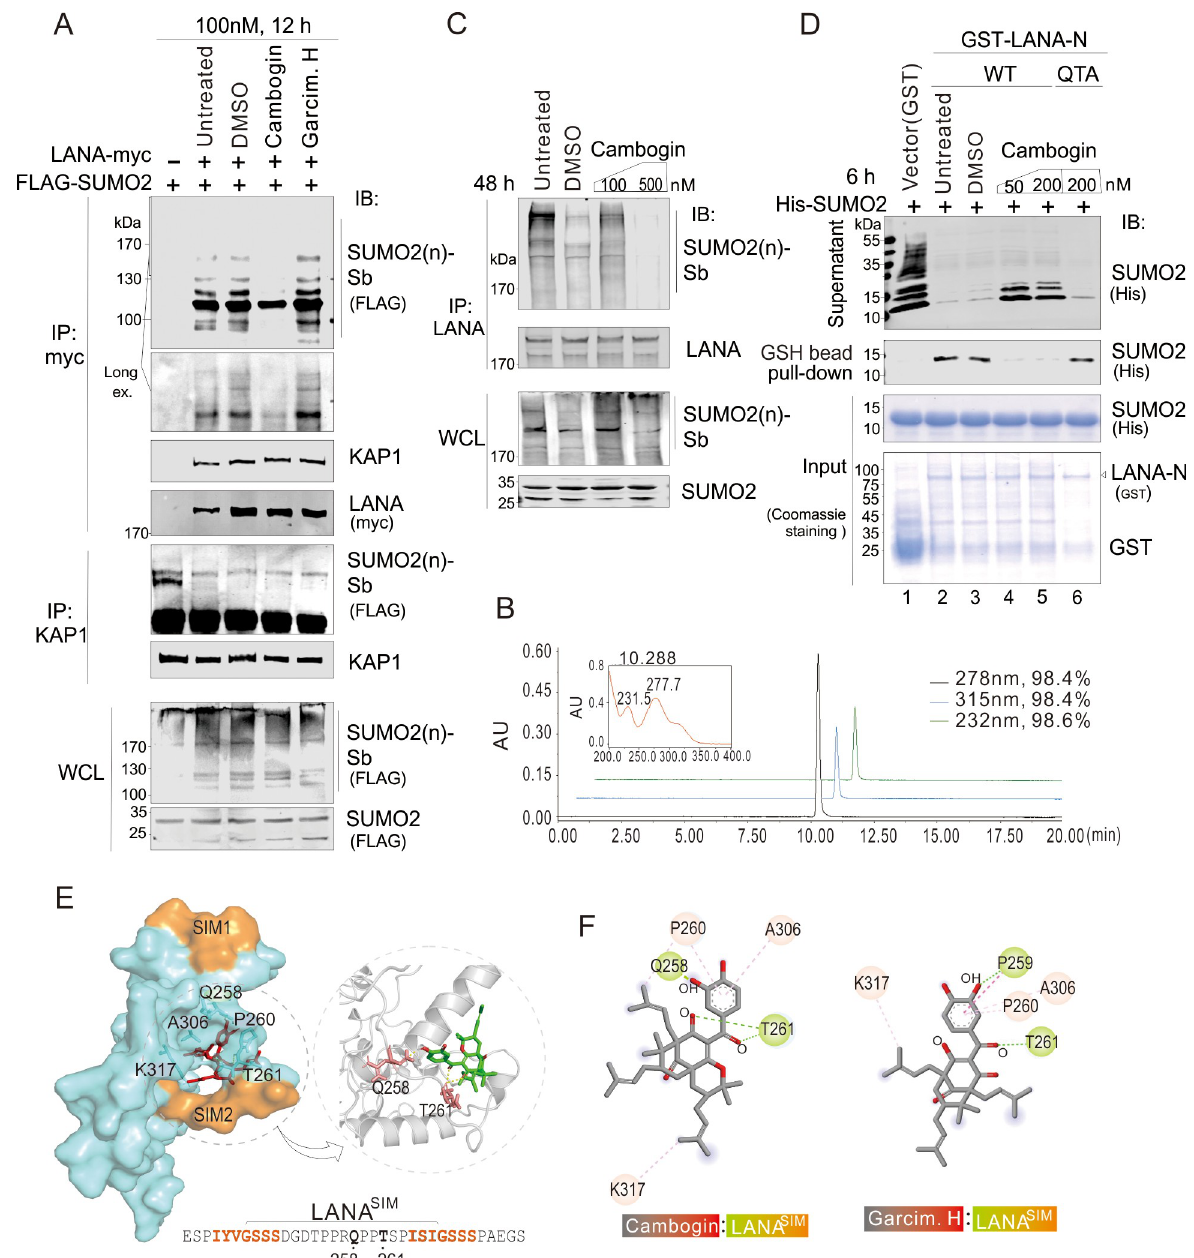
Fig 2. Cambogin specifically blocks the association of LANA SIM with SUMO2. ( A ) Cambogin but not Garcimultiflorone dramatically blocked the intracellular interaction of exogenous LANA and SUMO2. Whole cell lysates (WCL) from HEK293 cells transfected with myc-tagged LANA and FLAG-tagged SUMO2 were individually treated with compound (100 nM final concentration), DMSO or untreated for 12 h at 24 h post- transfection, and subjected to immunoprecipitation (IP) and immunoblotting (IB) with the indicated antibodies. The LANA-interacting SUMO2 modified substrates [SUMO2(n)-sb] is shown in line. The position ( > 170 kDa) of SUMO2 modified substrates [SUMO2(n)-sb] from immunoprecipitated complex is enlarged. ( B ) UPLC chromatogram of Cambogin. Purity of Cambogin was shown on the right panel. ( C ) Cambogin efficiently inhibited the interaction of endogenous LANA and SUMO2 in PEL cells. Whole cell lysates (WCL) from BCP1 cells were individually treated with (100, 500 nM) Cambogin or DMSO for 48 h, and subjected to immunoprecipitation (IP) and immunoblotting (IB) with the indicated antibodies. The untreated group was used as a control. The LANA-interacting SUMO-2 modified substrates [SUMO2(n)-sb] is shown in line. ( D ) Cambogin efficiently blocked the interaction between LANA and SUMO2 in vitro . Equal protein amounts of purified His-SUMO2 were co-incubated with GST or GST-LANA-N (WT or QTA) fusion proteins in vitro for 12 h, followed by treatment with different dosages of Cambogin for another 6 h. Untreated and DMSO were used as control groups. Glutathione (GSH)-sepharose beads were used and results were analyzed by immunoblotting (IB) with the indicated antibodies. An aliquot of the purified His-SUMO2 fusion proteins was also applied directly to the gel